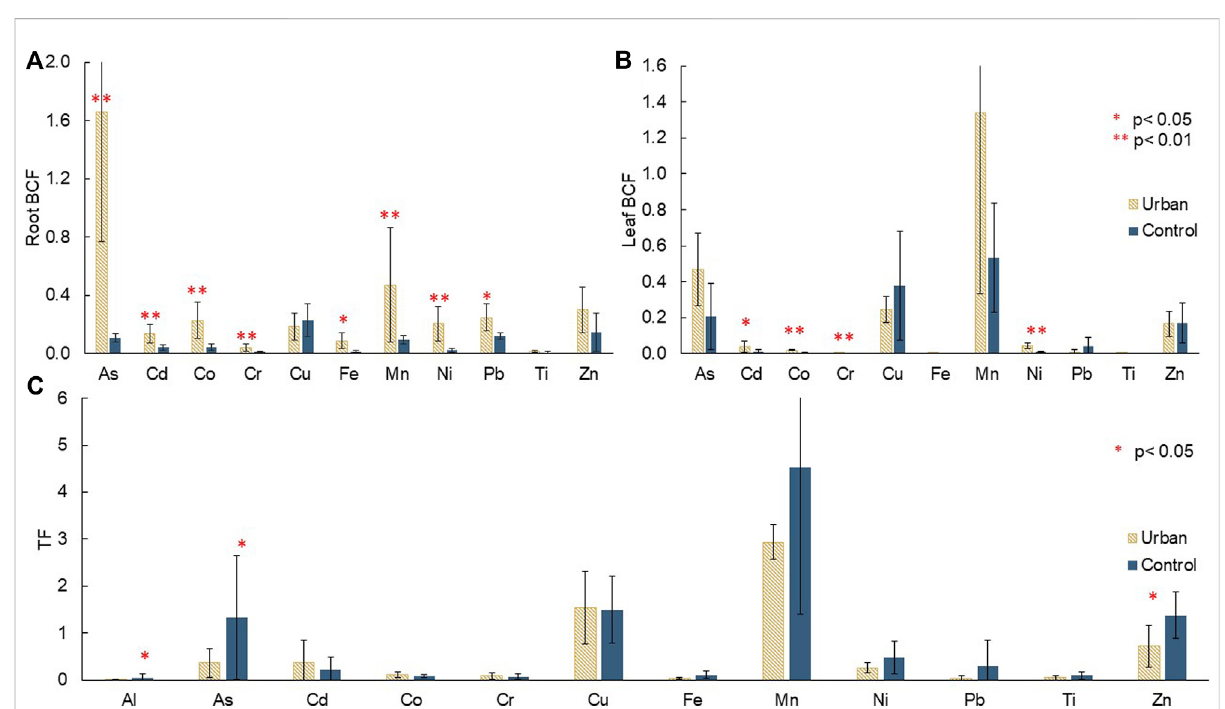
FIGURE 5 Mean (A) root bioconcentration factors (root BCF), (B) leaf bioconcentration factors (leaf BCF), and (C) translocation factors (TF) with error bars correspondingtostandarddeviationoftriplicatesforbothspecies( A.marina and R.stylosa )attheurbanandcontrolsites,withsigni fi cantdifferences